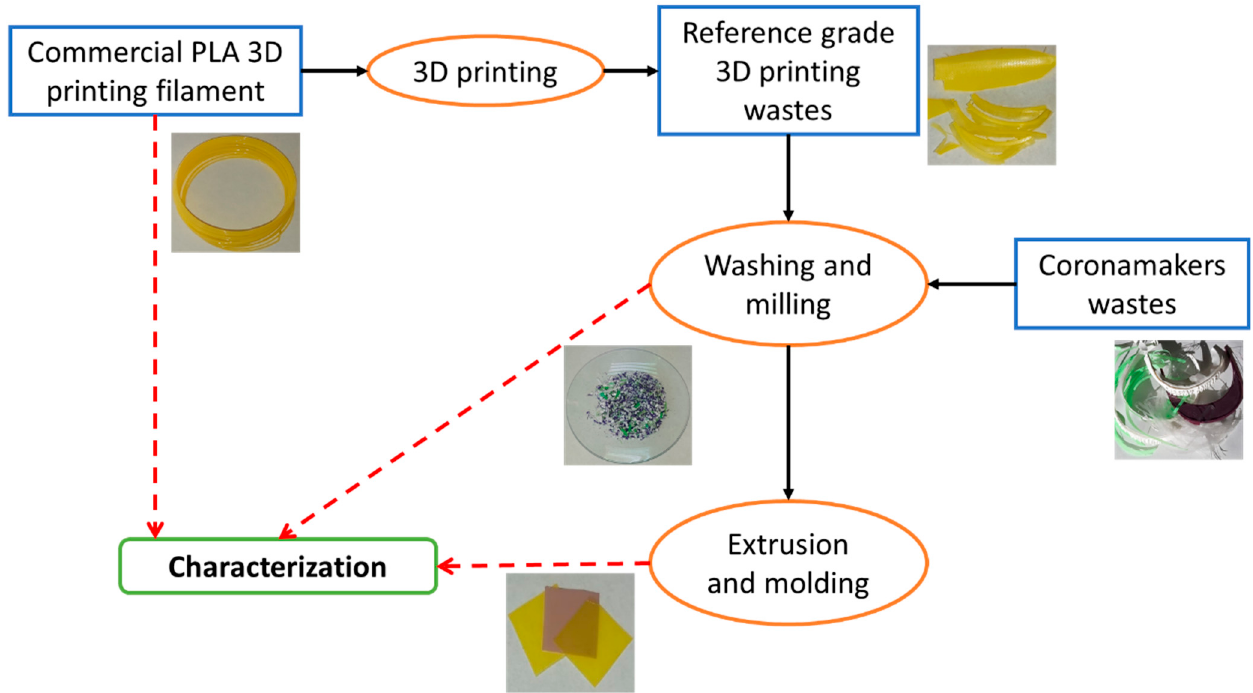
Figure 1. Scheme of the mechanical recycling process.